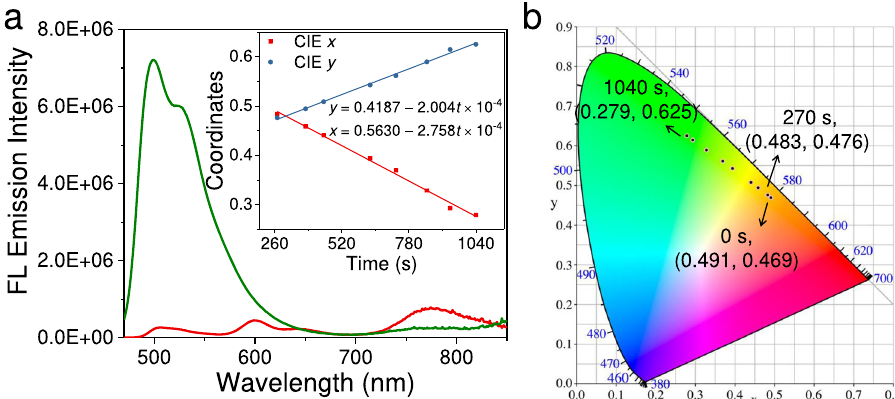
Fig. 7 Emission color tuning of the ternary supramolecular copolymers 1/2/3. a Fluorescent emission spectral changes of supramolecular copolymers 1 / 2/3 without light irradiation (red line) and with 460 nm light irradiation for 36.5 min (green line). Inset: changes of CIE ( x , y ) coordinates versus the 460 nm irradiation time ( t ). b CIE coordinate changes upon 460 nm irradiation. The measured concentrations are 8.0× 10 − 5 mol L − 1 for 1 , 1.6× 10 − 5 mol L − 1 for 2 , and 8.0× 10 − 6 mol L − 1 for 3 in from pale brown (0.483 and 0.476) to green (0.279 and 0.625) (Fig. 7b). By plotting CIE coordinates ( x , y ) versus irradiation time, linear relationships are established to describe CIE ( x , y ) variations during this period, namely CIE ( x = 0.5630 − 2.758t × 10 − 4 , y = 0.4187 + 2.004t × 10 − 4 , Fig. 7a, inset). Upon switching the